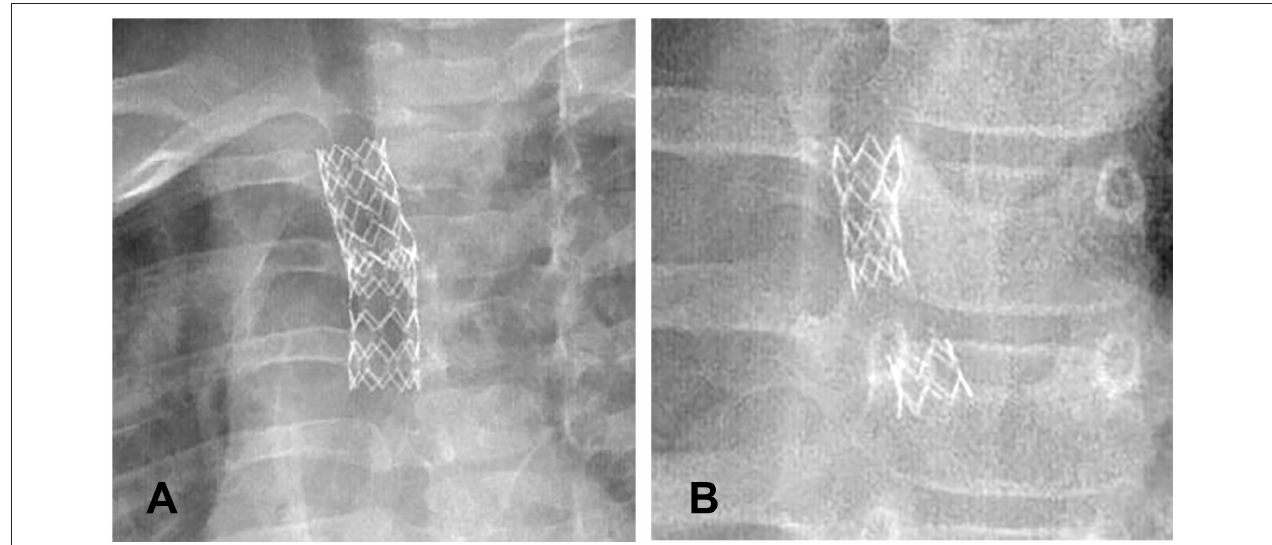
FIGURE 4 | (A) Two airway stents overlapping in the central airway. (B) Main airway stent breakage.